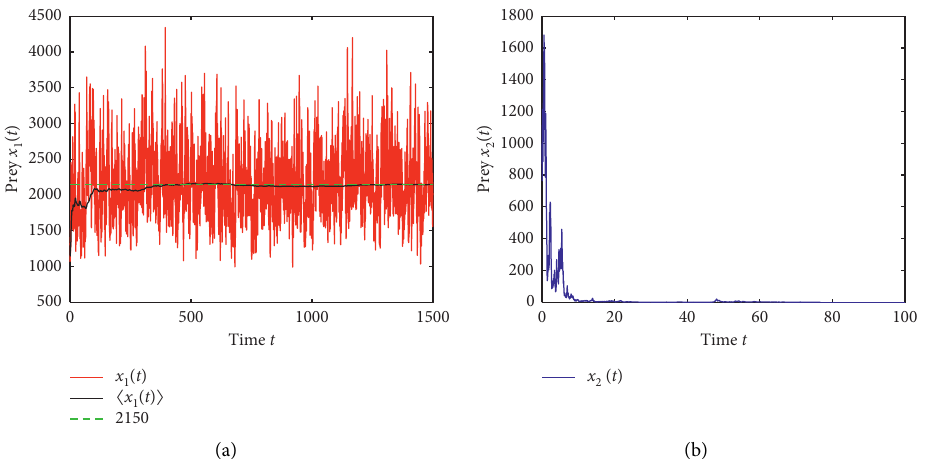
Figure 9: t The trajectories of stochastic model (5) with σ 2 ( t ) and (b) prey x x 1